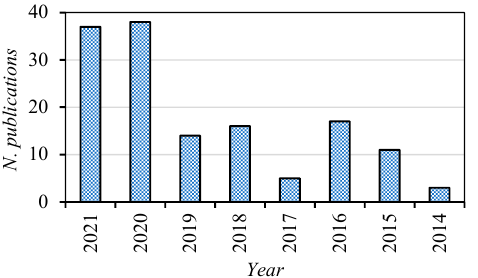
Figure 2. Temporal distribution of the reviewed journal articles.